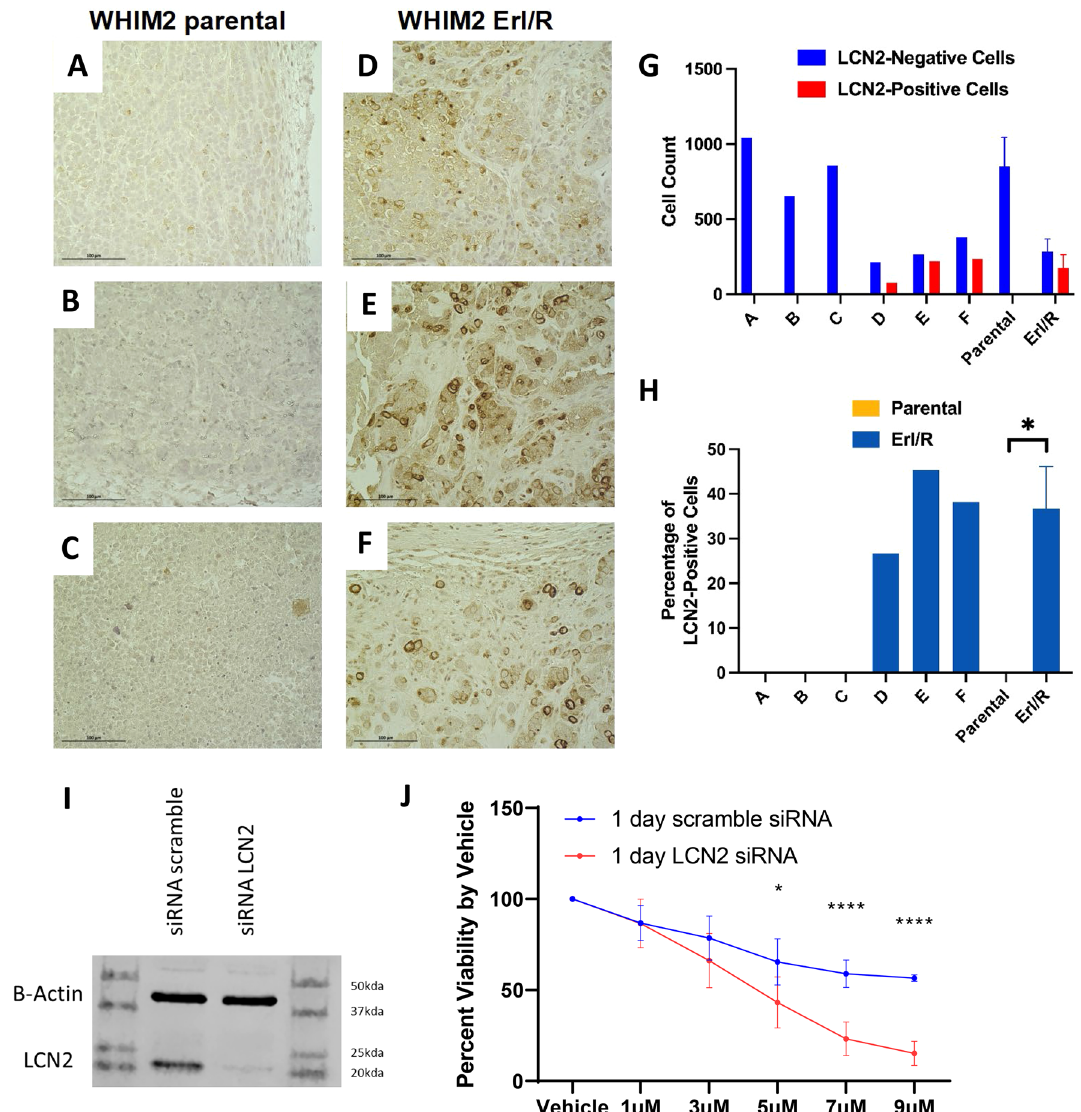
Figure 6. ( A – F ) Representative images of immunohistochemical staining for LCN2 on formalin-fixed, paraffin- embedded WHIM2 parental and WHIM2 Erl/R mammary gland tumors; ( G ) Quantification of LCN2-negative cells and LCN2-positive cells in each image; ( H ) Percentage of total cells in the image that were LCN2-positive ( P = 0.021). ( I ) Western blot of lysates from LCN2 siRNA and non-targeting siRNA transfected WHIM2 erlotinib-resistant PDX cells. ( J ) Erlotinib treatment on WHIM2 erlotinib-resistant PDX cells with LCN2 siRNA or non-targeting siRNA transfection ( P < 0.05 at 5 μM, P < 0.001 at 7 μM and 9